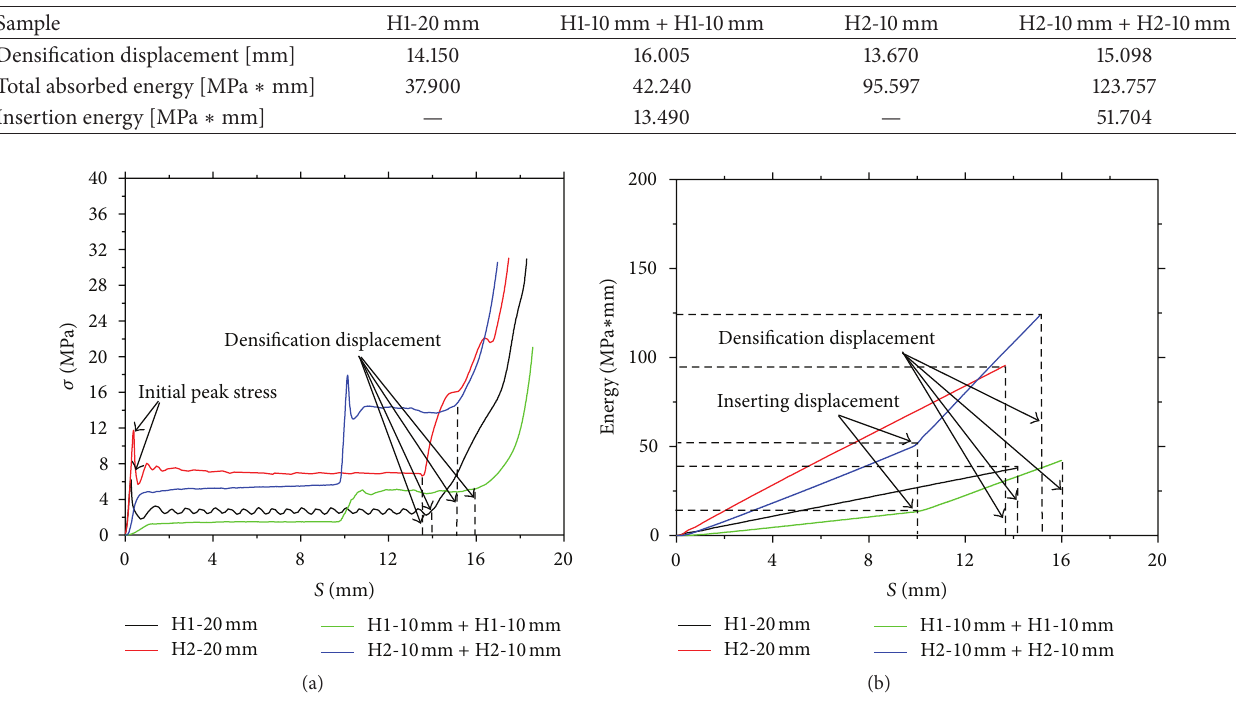
Table 5: Energy-absorbing parameters of different honeycomb samples.